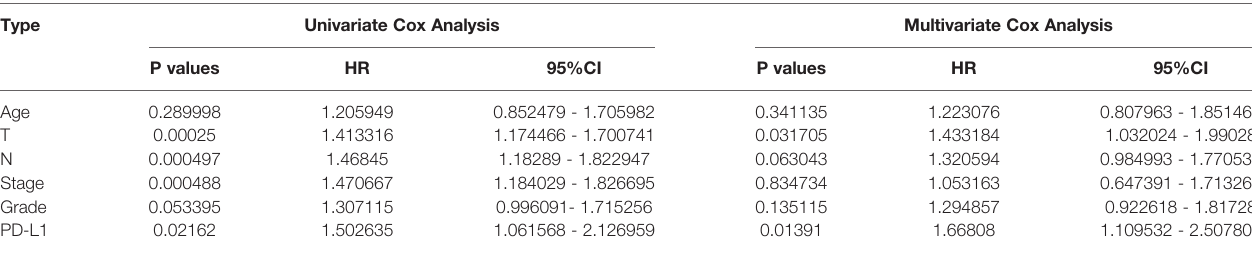
TABLE 1 | Prognostic value of PD-L1 expression in